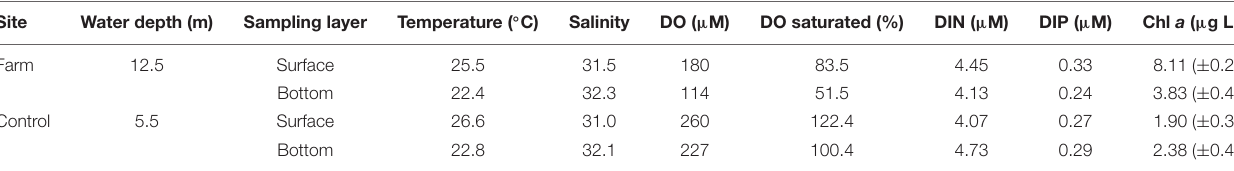
TABLE 2 | Environmental parameters in the water column of the fish farm and control sites.